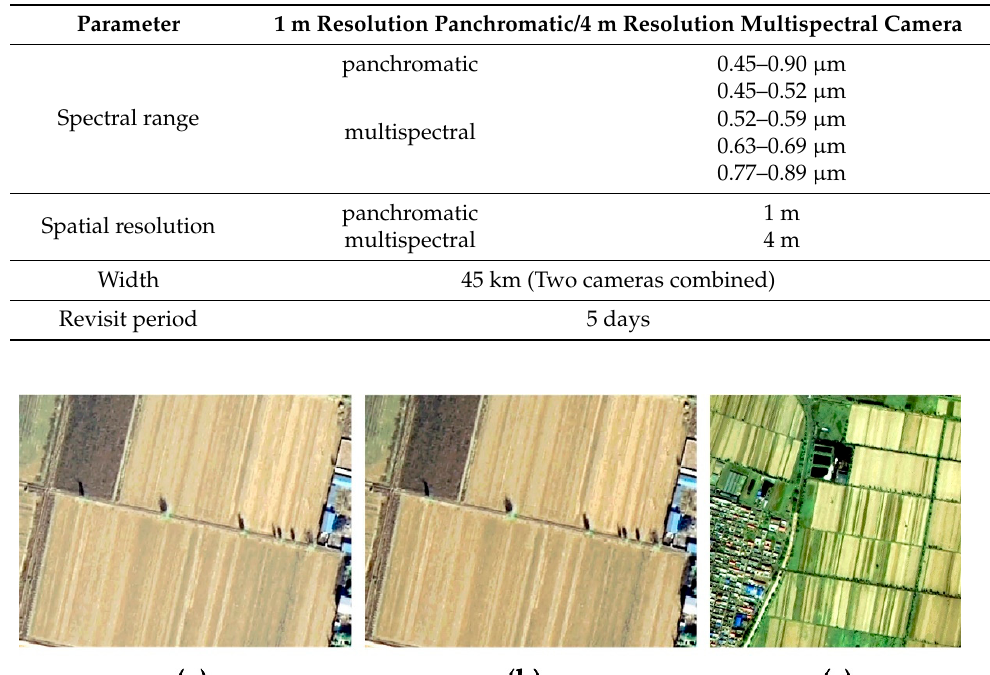
Table 1. Technical parameters of the GF-2 satellite. Figure 1. Geographical location of the study area.